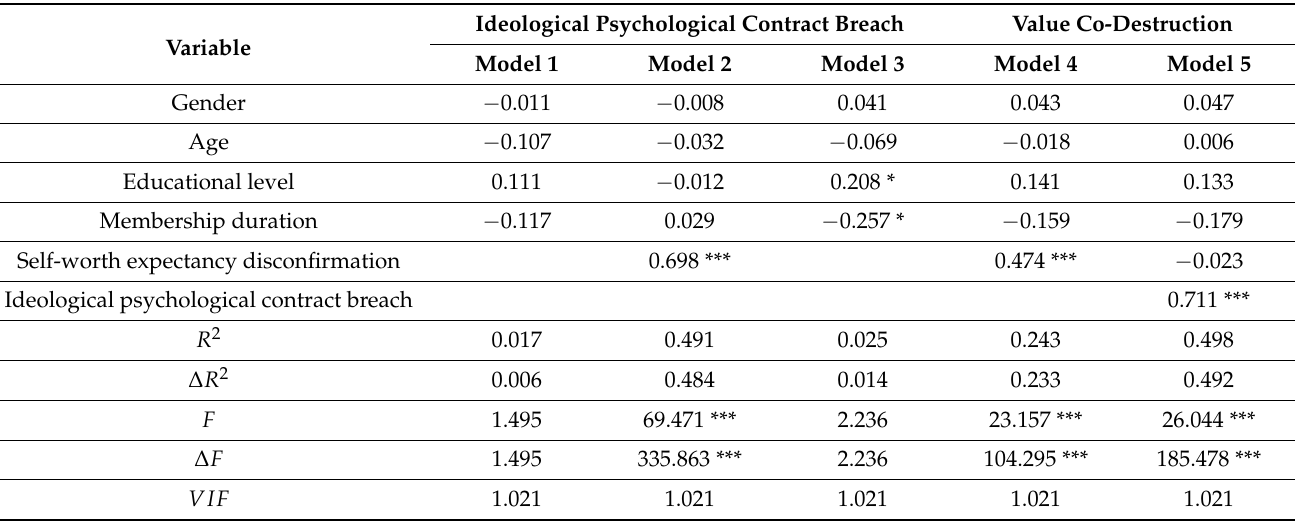
Table 8. Direct effect of self-worth expectancy disconfirmation and mediating effect of ideological psychological contract breach on value